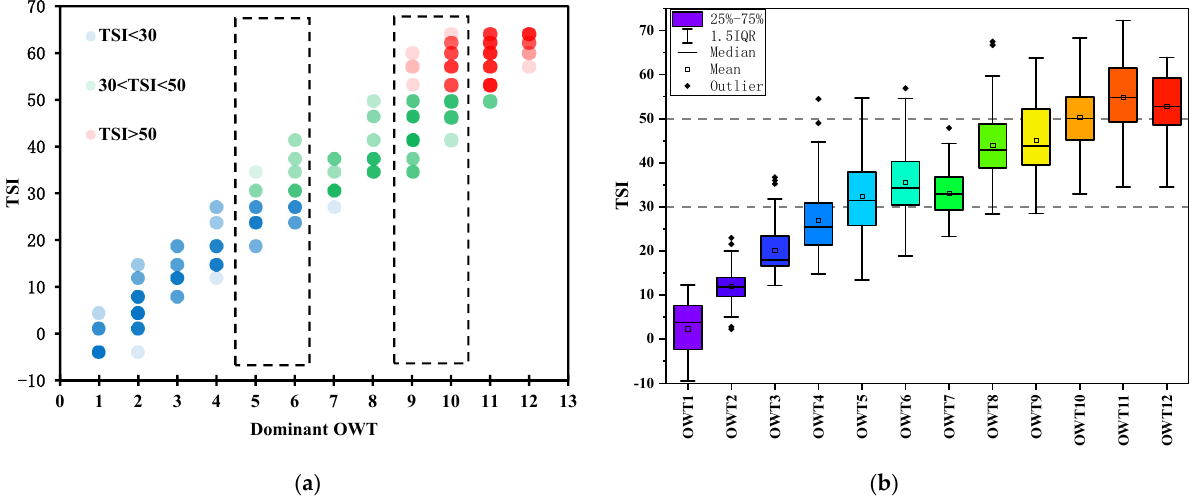
Figure 10. The relationships between the U-OWT and Chla-based TSI. ( a ) Scatterplot of data pairs of Chla-based TSI and U-OWT dominant OWT from the IOCCG synthetic SeaWiFS convolutional R rs ( λ ) ( N = 500). Two boxes with black dashes mark the dominant OWT5-6 (transition between oligotrophic and mesotrophic waters) and the dominant OWT9-10 (transition between mesotrophic and eutrophic waters). The points are plotted with 85% transparency to show the data density. ( b ) Chla-based TSI distributions of NOMAD and CCRR in situ measurements corresponding to different U-OWT dominant OWT (OWT1-OWT12). OWT13/14/15 are not shown here because of the lack of observations.